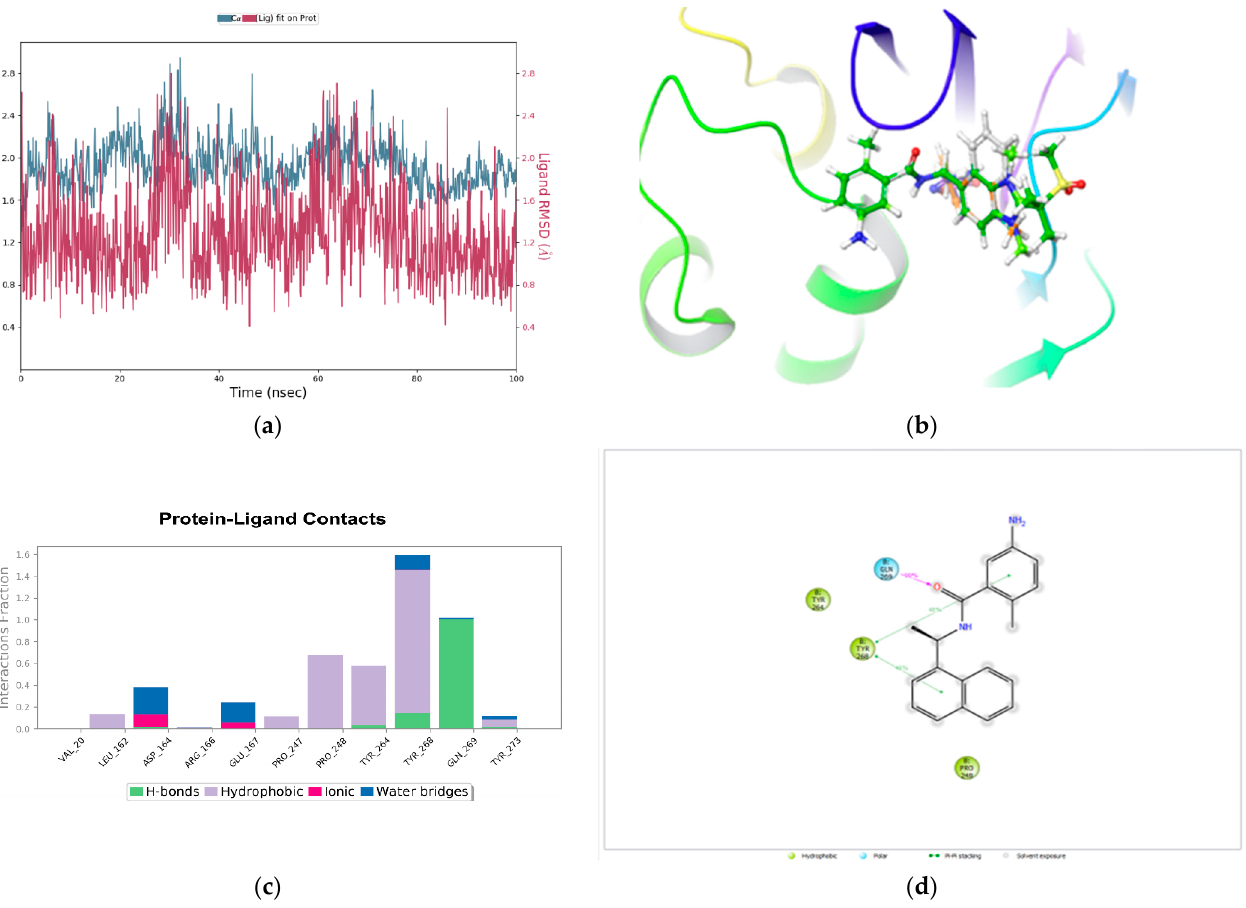
Figure 5. MD simulation of x-ray crystallography solved structure 7JIR and MCS docking overlay of the design ideas using the binding mode of GRL-0617 as a reference compound. ( a ) Root-mean-square deviation of GRL-0617 in the active site cavity of SARS-CoV-2 PL pro obtained with an MD simulation time of 100 ns. ( b ) MCS docking overlay of design ideas selected prioritized and FEP+ amenable with GRL-0617 (grey carbon atoms) as a reference compound taken with the 100 ns MDS optimized frame. The carbon atoms of GRL-0617 are shown in grey, compound 45 in green, compound 91 in orange, compound 5 in faded green, and compound 23 in violet. The amino acids in the active site cavity were removed to provide a clear depiction of the overlay of the structures. ( c ) Histogram detailing the interaction between GRL-0617 and PL pro . ( d ) Ligand interaction diagram revealing hydrogen bonds, π – π , and hydrophobic interactions between GRL-0617 and PL pro .